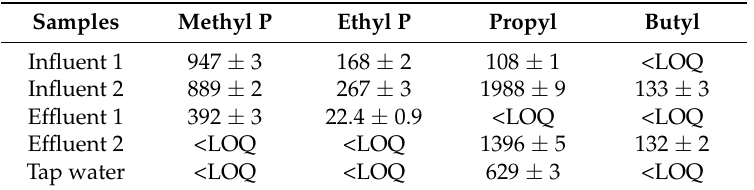
Table 6. Analysis of parabens in real samples (concentration in ng L − 1 ) using in-syringe MSPE/ HPLC-DAD, n = 6, degrees of freedom = 5.